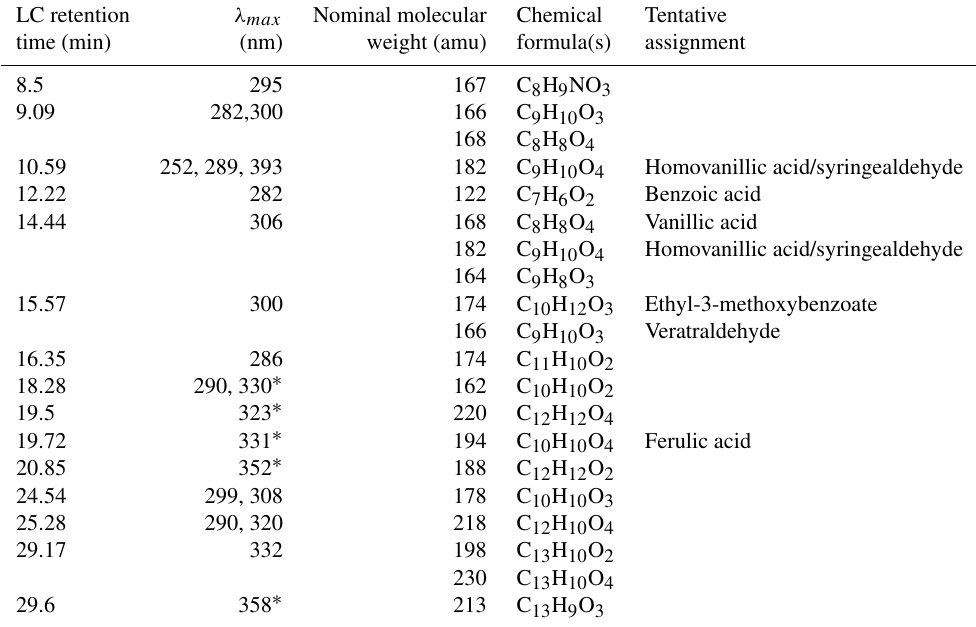
Table 4. The list of retention times, absorption peak maxima, and chemical formulas of the BrC chromophores detected in the dung smoke sample. Tentative assignments are given based on compounds previously identified in the lignin pyrolysis